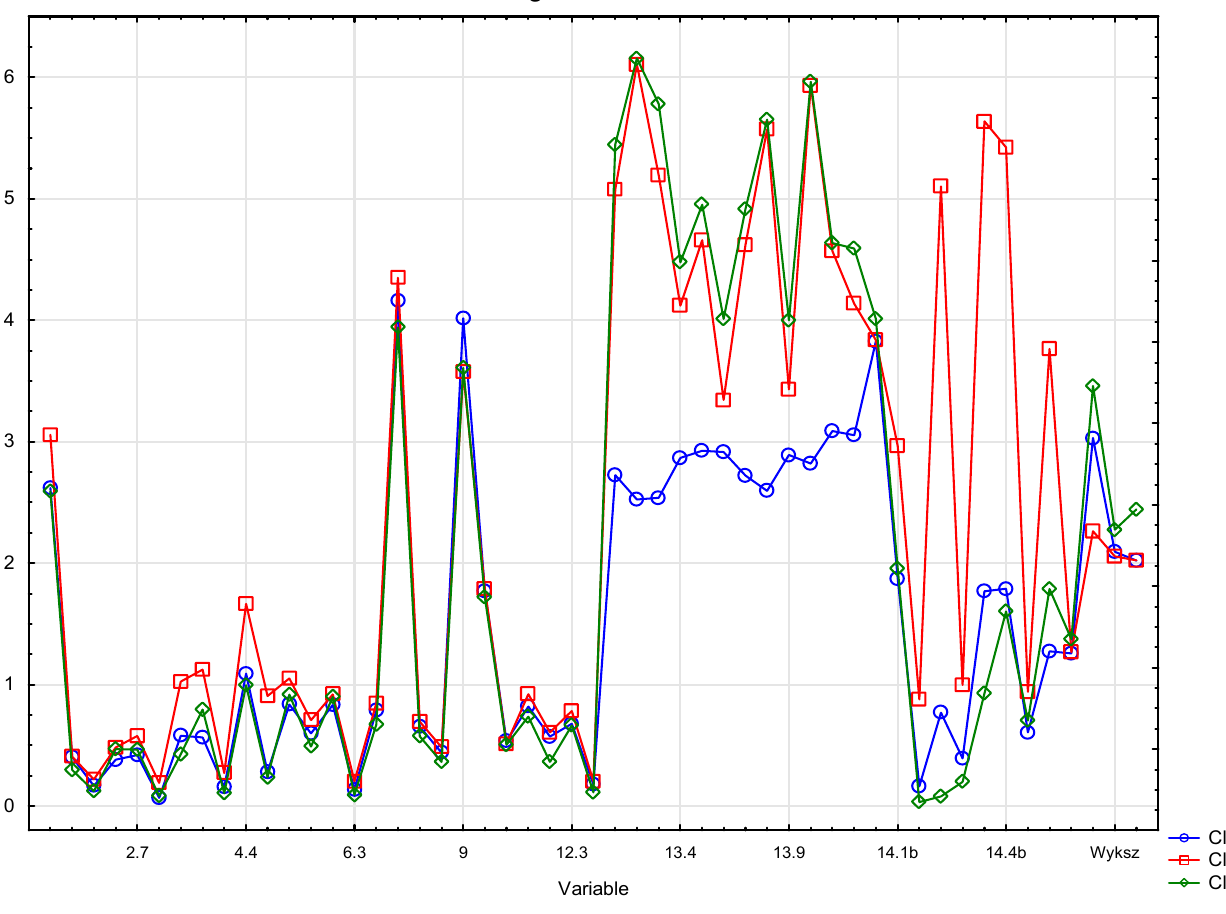
Figure 4. Average values for all variables in three clusters.